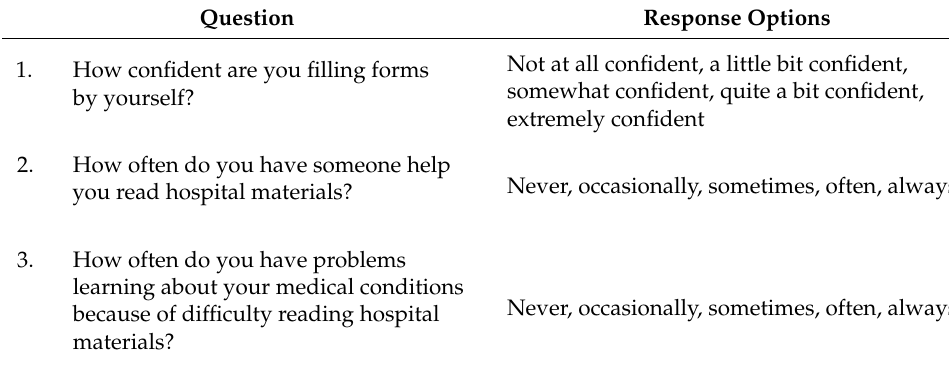
Table 1. Questions and response options for the brief health literacy screen (BHLS).